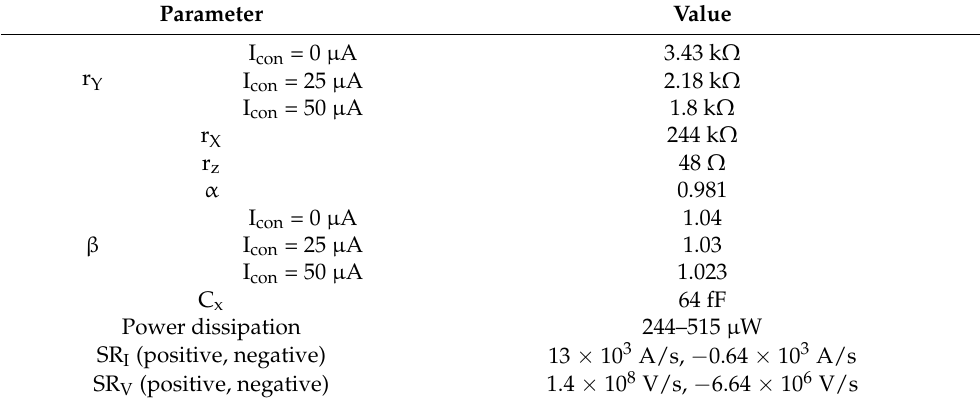
Table 1. The simulated characteristics of VCII - with electronically variable impedance at the Y port. Parameter